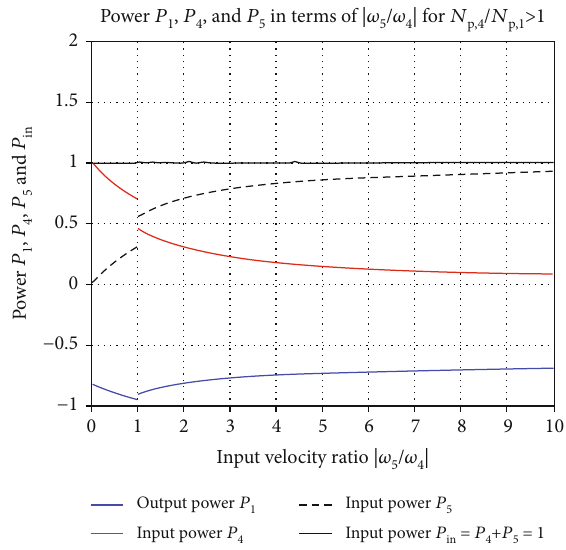
Figure 13: Input and output powers with input velocity